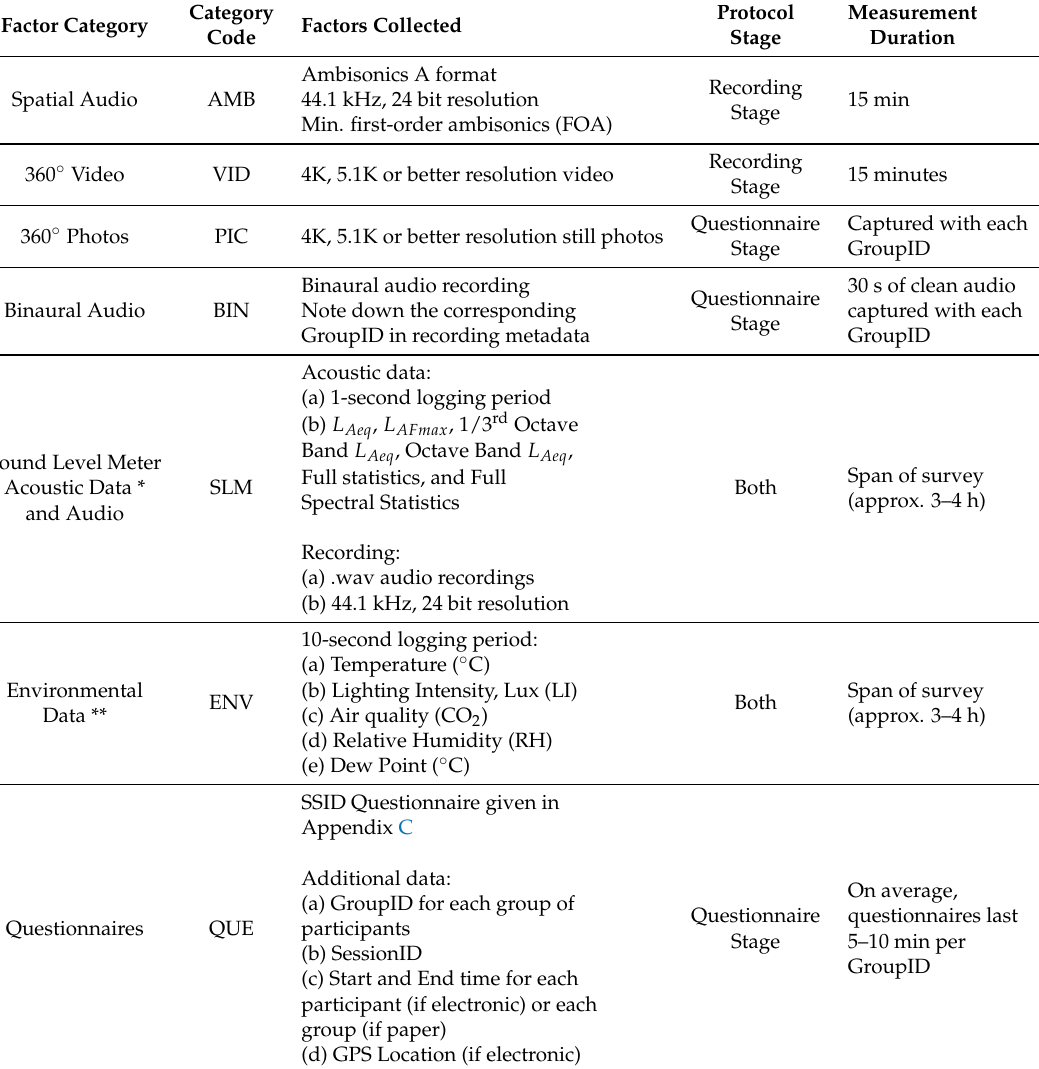
Table 3. Table of recommended context and acoustic measurement